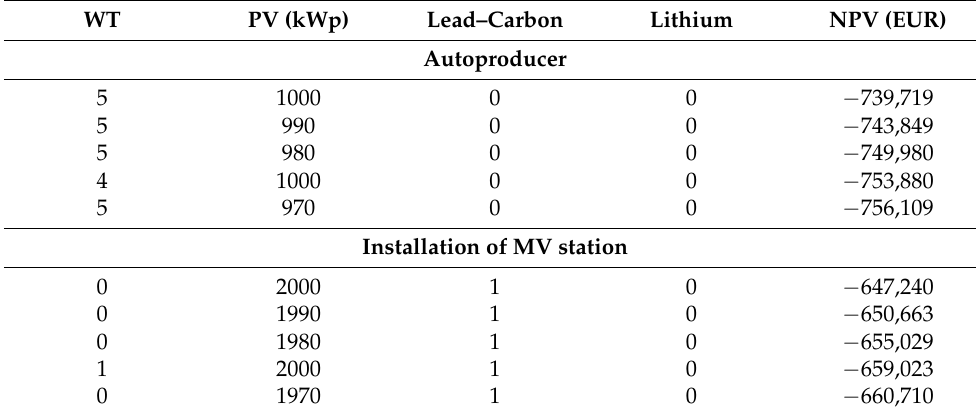
Table 12. Optimal results for Stockholm